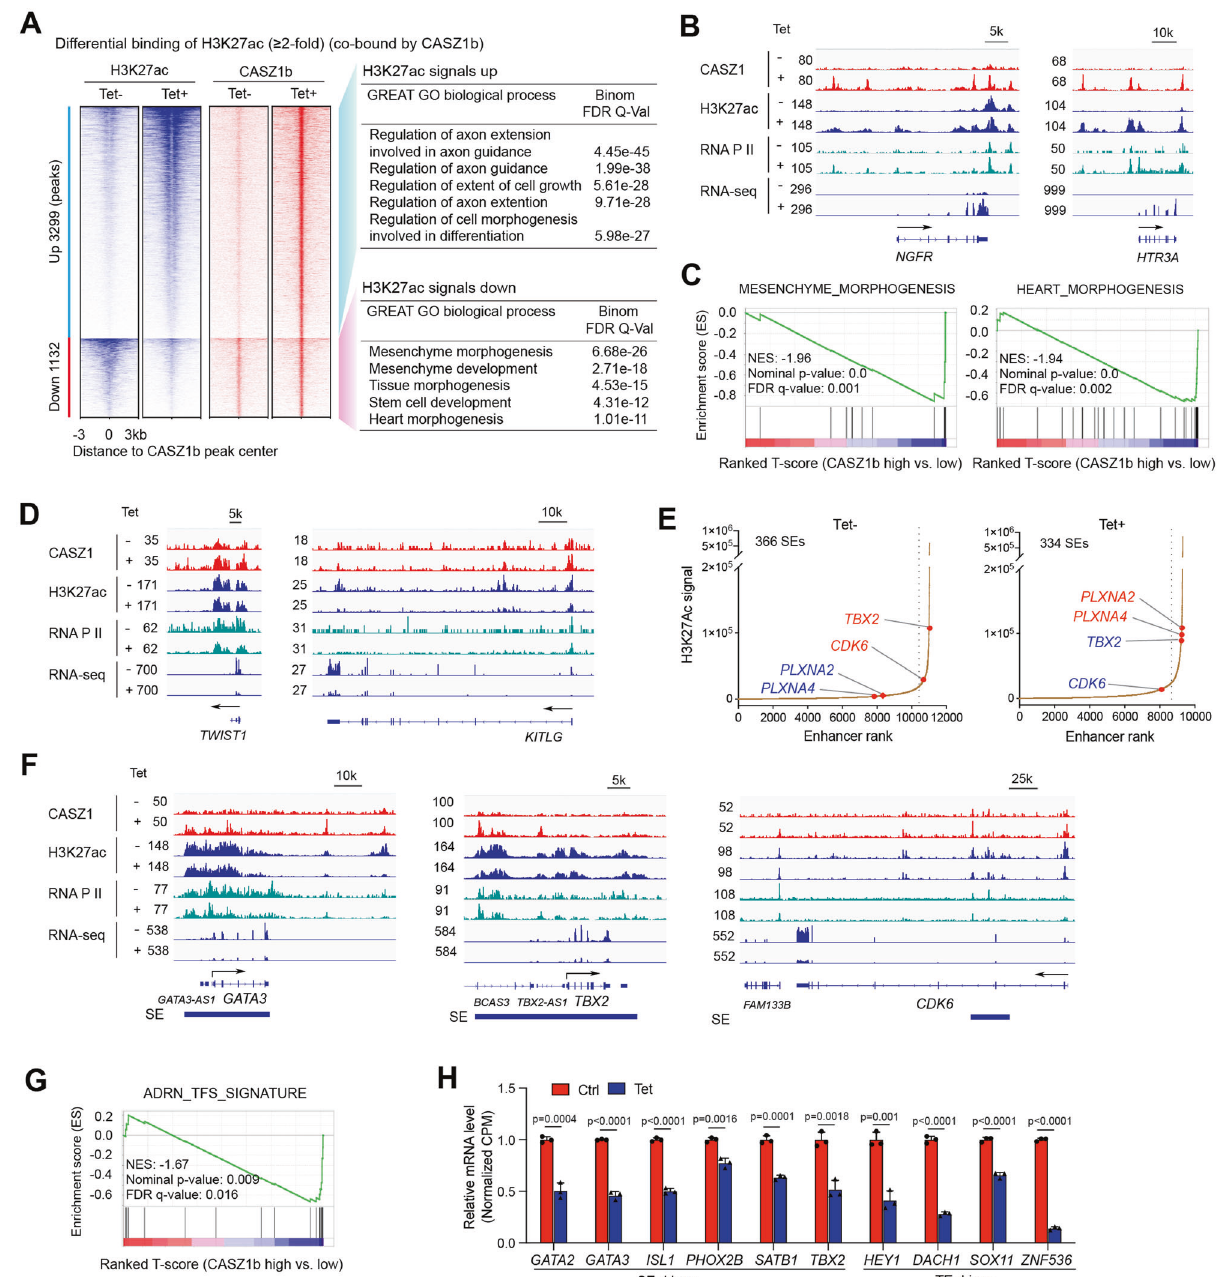
Fig. 6 CASZ1b represses NB CRC and mesenchymal signature genes and activates neuronal genes through affecting enhancer activity. A Restoration of CASZ1b in SY5Y cells results an increase of H3K27ac signals (heatmap on the left) on genes that are associated with axonogenesis (GO analysis on the right) and a decrease of H3K27ac signals on genes (heatmap on the left panel) that are associated with mesenchyme development (GO analysis, right panel). B Signal tracks show the increase of CASZ1b, H3K27ac and RNA Pol II signals and RNA- seq signals on the neuronal genes NGFR and HTR3A after induction of CASZ1b (Tet + vs. Tet − ). C GSEA shows a negative enrichment of mesenchyme morphogenesis and heart morphogenesis genes upon induction of CASZ1b in SY5Y cells. D Signal tracks show the increase of CASZ1b signals, and decrease of H3K27ac, RNA Pol II and RNA-seq signals on the mesenchyme development regulators TWIST1 and KITLG after induction of CASZ1b (Tet + vs. Tet − ). E Restoration of CASZ1b in SY5Y cells re-organizes SEs. The histograms show an increase of H3K27ac signal on neuronal genes PLXNA2 and PLXNA4 and a decrease of H3K27ac signals on CRC component TBX2 , as well as cell cycle progression regulator CDK6 . F Signal tracks show that the restoration of CASZ1b in SY5Y cells results in a decrease of SE signals (H3K27ac), as well as RNA Pol II signals and RNA-seq reads on GATA3 and CDK6 ; G GSEA shows that the restoration of CASZ1b in SY5Y cells results in a signi fi cant negative enrichment of noradrenergic NB TFs coding genes. H The bar graph shows the negative regulation of noradrenergic NB TFs coding genes that either driven by SEs or typical enhancers (TEs) in SY5Y cells after restoration of CASZ1b based on the normalized RNA- seq reads (CPM: counts per million). Data represent mean ± SEM, n = 3 biological replicates. Two-sided Student ’ s t test was used to calculate statistical